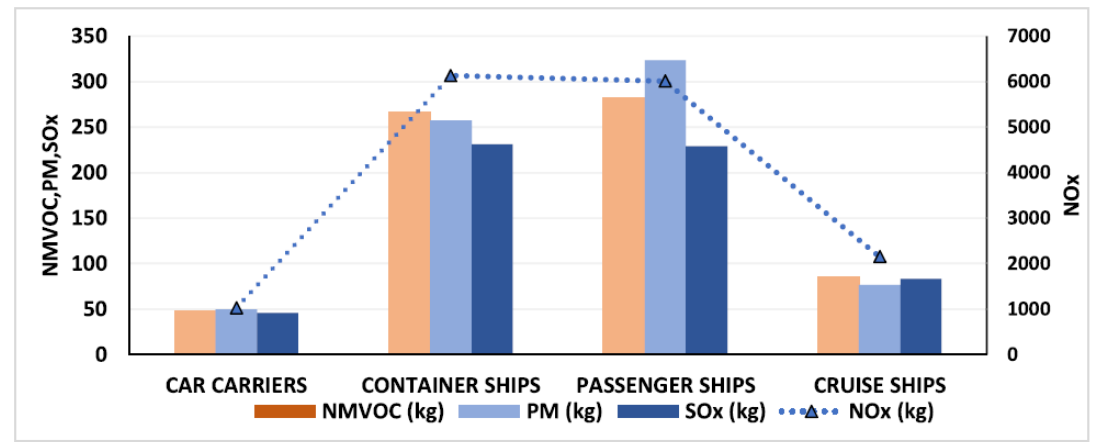
Figure 13. Emissions in Piraeus Port in 2018. Reprinted with permission from ref. [46]. Copyright © 2020 Elsevier Ltd. All rights reserved.